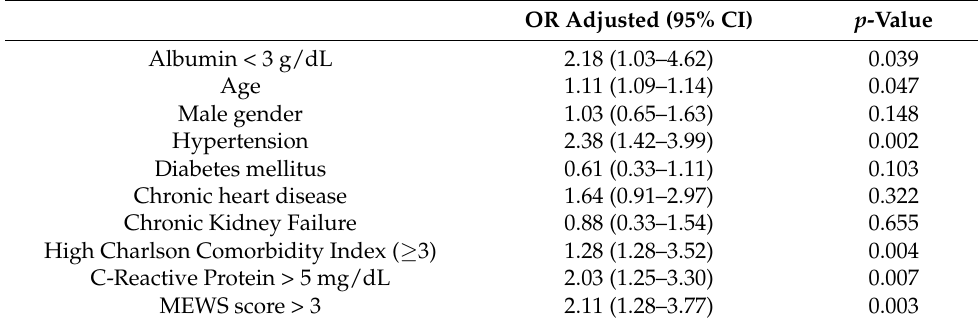
Table 3. Adjusted Odds ratios (OR) for in-hospital mortality in older adults admitted with SARS- CoV-2